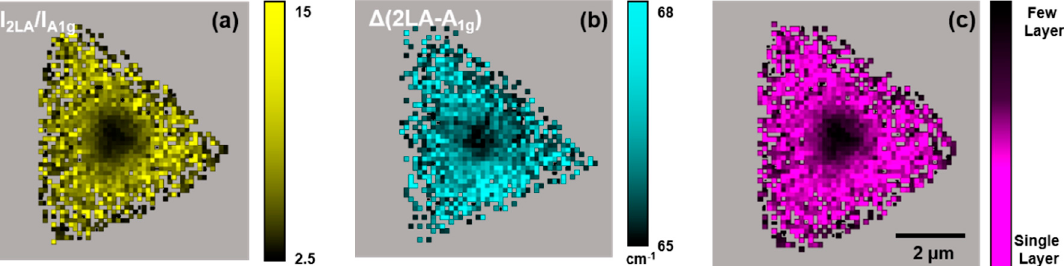
Figure 3. Typical WS 2 layer count maps for a single WS 2 flake on TSG. ( a ) I 2LA / I A1g intensity ratio map. ( b ) Δ (E 2LA − E A1g ) band energy difference map. ( c ) Combined a and b WS 2 layer count map.